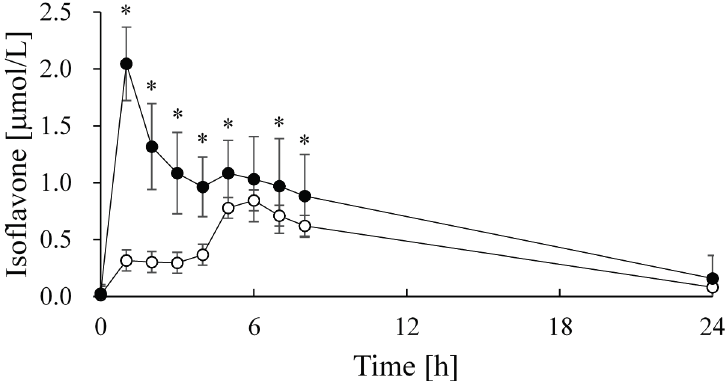
Figure 1. Serum concentration of total isoflavones in healthy adult subjects after the ingestion of soy milk or fermented soy milk beverage [23]. White circle, soy milk; black circle, fermented soy milk beverage. Data were expressed as the mean ± SD ( n = 12) and were evaluated using a paired t -test. * p < 0.05. Data from Kano M. et al. , J. Nutr . 2006